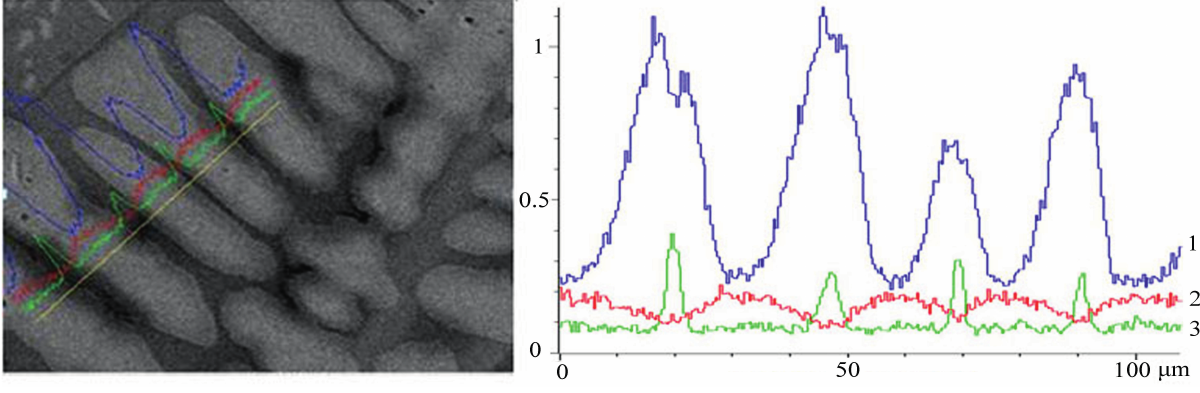
Figure 3. A backscattered electron image of the longitudinal section of the DS sample withdrawn at 18 mm = min and the line scanning curves of Ti (1), Nb (2) and Si (3).